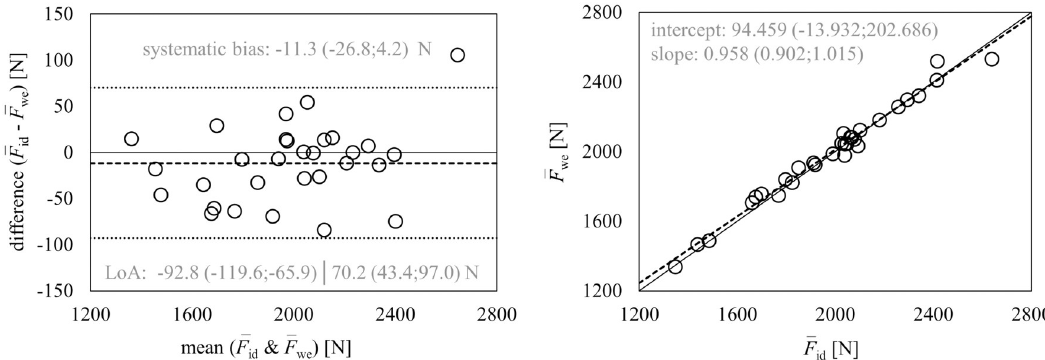
Fig 1. Results of the Bland-Altman analysis (left) and Deming regression (right) for the comparison between � F Deming regression plot with the fitted linear model (dashed line) and the identity line ( � F Altman plot with mean difference between methods (dashed line) and 95% limits of agreement (dotted lines). Regression parameters were reported as slope/intercept with 95% confidence limits, difference was reported as mean with 95% confidence limits, limits of agreement were reported as systematic bias ± 1.96 × SDD with 95% confidence limits. � F from inverse dynamic approach, � F = mean vertical barbell force computed from work-energy approach, LoA = limits of we